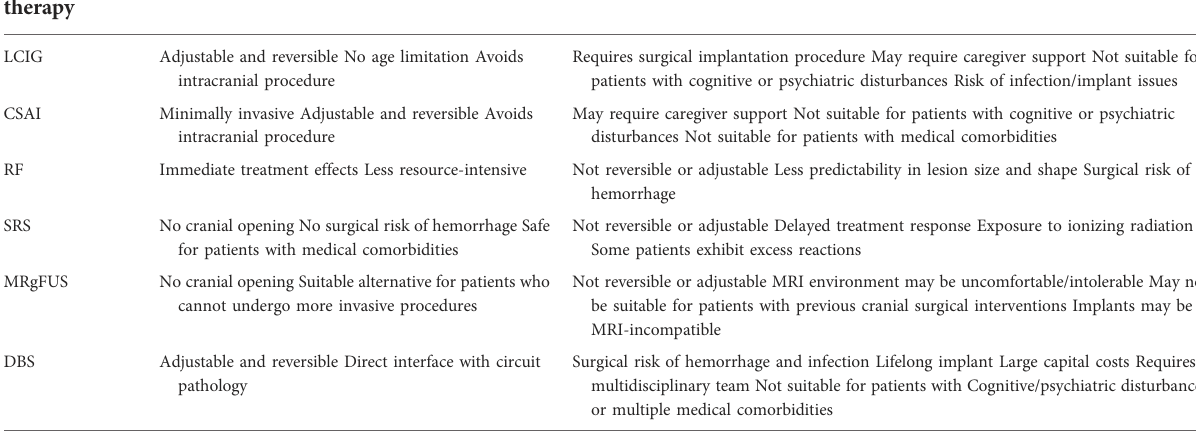
TABLE 3 Advantages and drawbacks of advanced